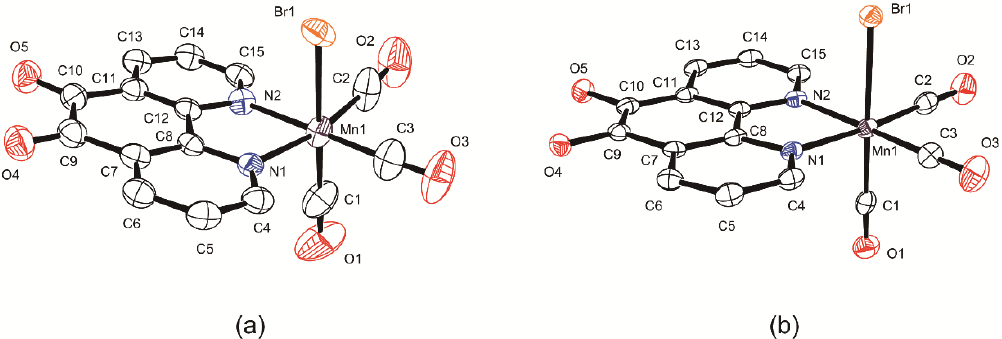
Figure 3. Molecular structures with atom labels and displacement ellipsoids for non-H atoms drawn at the 50% probability level. H atoms and the solvent molecule are omitted for clarity. ( a ) fac -